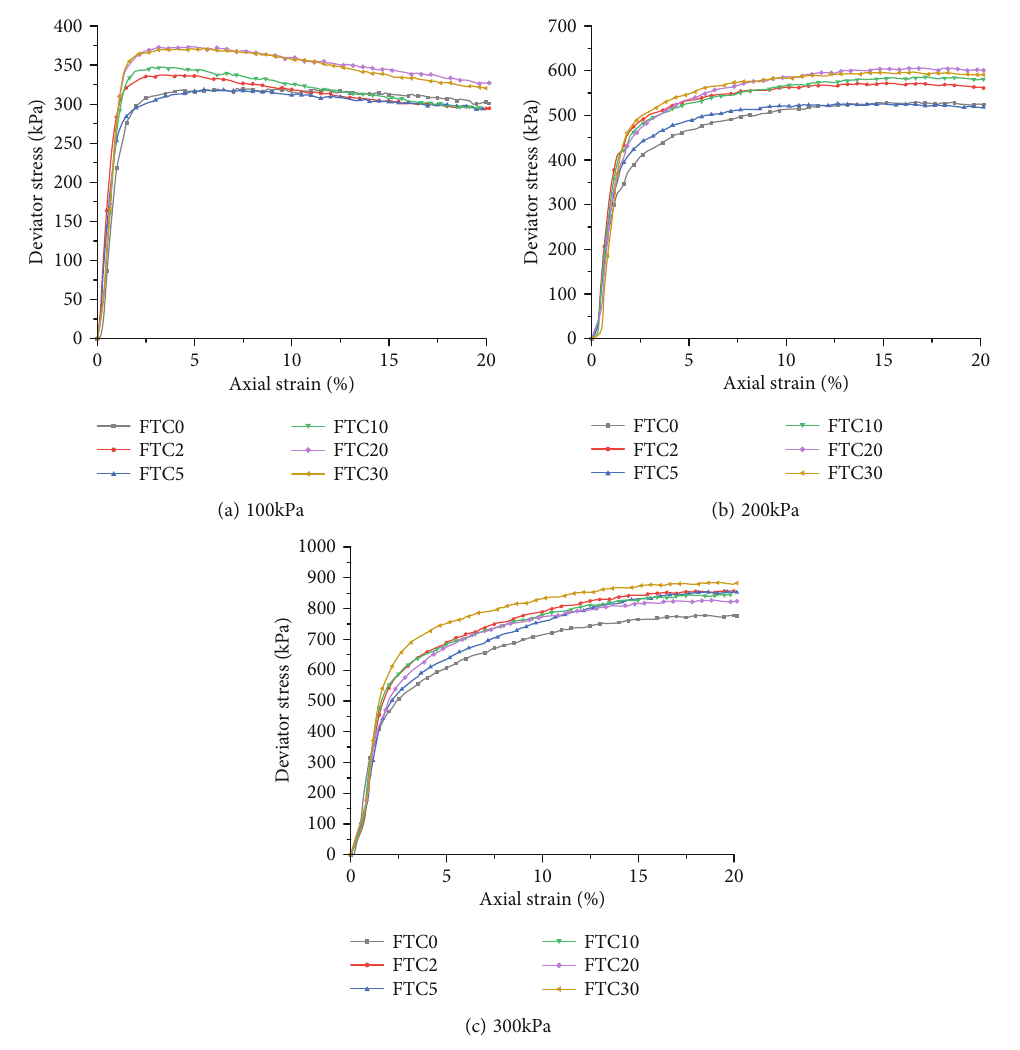
Figure 6: Stress-strain curve of basalt powder